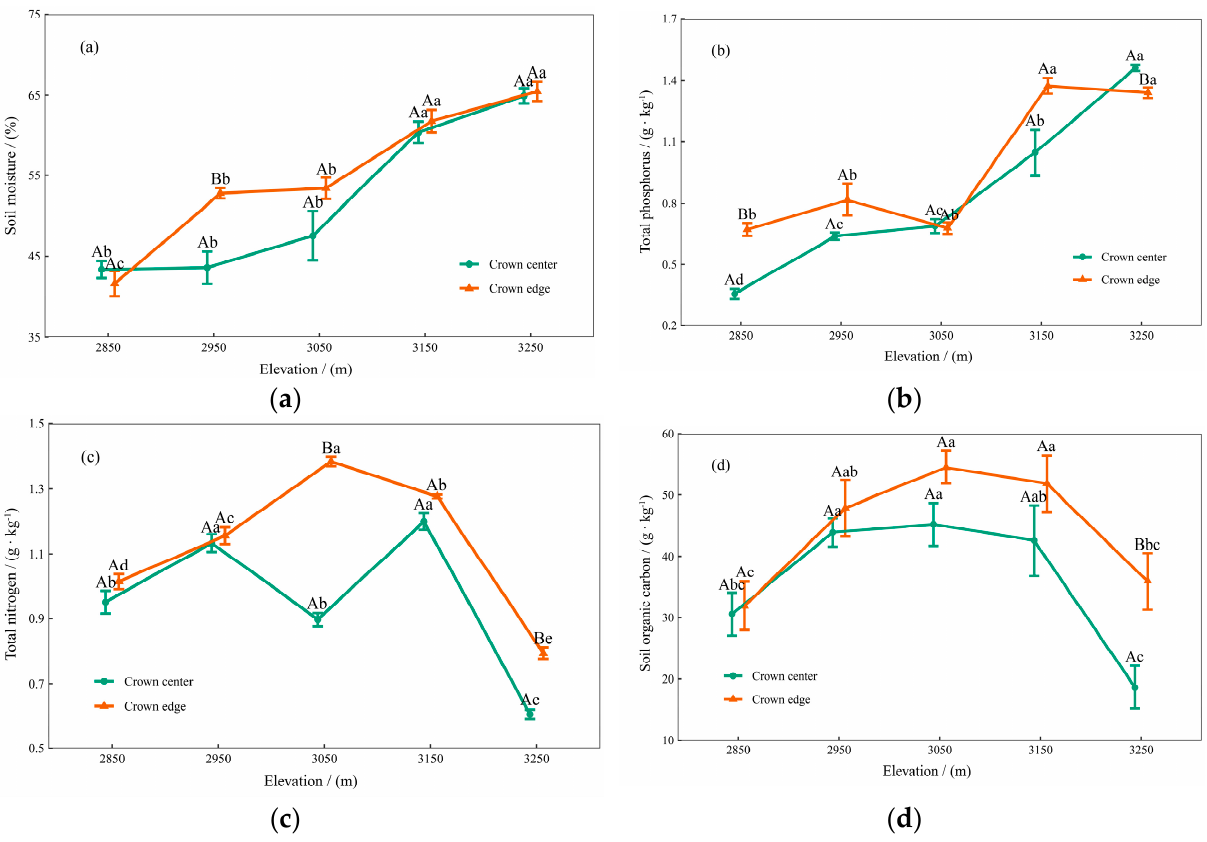
Figure 1. Soil physical and chemical properties of each study plot. The changes in soil moisture ( a ), total phosphorus ( b ), total nitrogen ( c ), and soil organic carbon ( d ) in study sample areas. Notes: Capital letters express significance between CC and CE; lowercase letters indicate significance between altitudes ( t -test, p < 0.05)